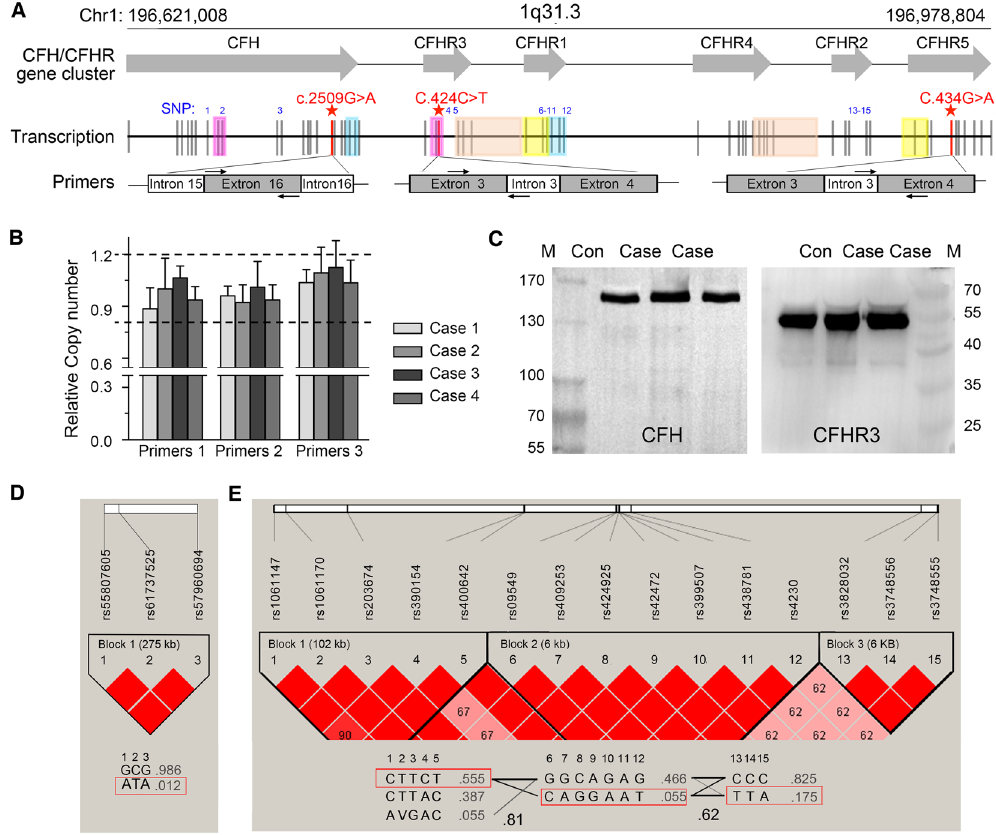
Figure 2. Genetic analysis of three rare SNPs and other 15 common SNPs. ( A ) Locations of rare rs55807605 (CFH c.2509 G > A), rs61737525 (CFHR3 c.424 C > T) and rs57960694 (CFHR5 c.434 G > A) are presented with red asterisk, corresponding to three pairs of primers specific of RS gene loci, while 15 other common SNPs are in blue number notation. Genomic duplications including the different exons of CFH, CFHR3 and CFHR5 are color-coded. Exons are indicated as vertical lines. ( B ) Relative copy number of three fragments of CFH, CFHR3 and CFHR5 linked with these SNPs in patients and controls measured by real-time quantitative PCR and T-tests were used to quantify significant differences between patients and controls (P < 0.05). ( C ) Western blotting bands of CFH and CFHR3 protein among cases and healthy controls. Linkage disequilibrium plots show that ( D ) three rare SNPs and ( E ) 15 common SNPs are all in linkage disequilibrium in the CFH gene cluster (n = 208; Chinese Han population). Haplotype frequencies and crossover frequencies between blocks are shown in the schematic,